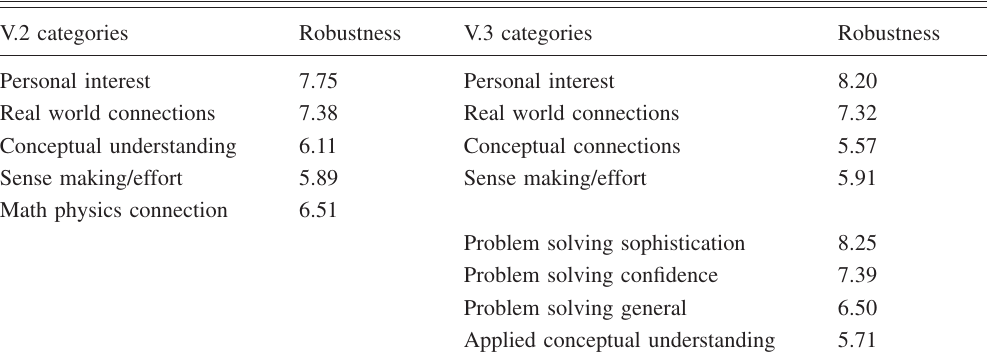
TABLE III. CLASS V.2 and V.3 category robustness ratings. These ratings were done on post data for calculus-based Physics I students at